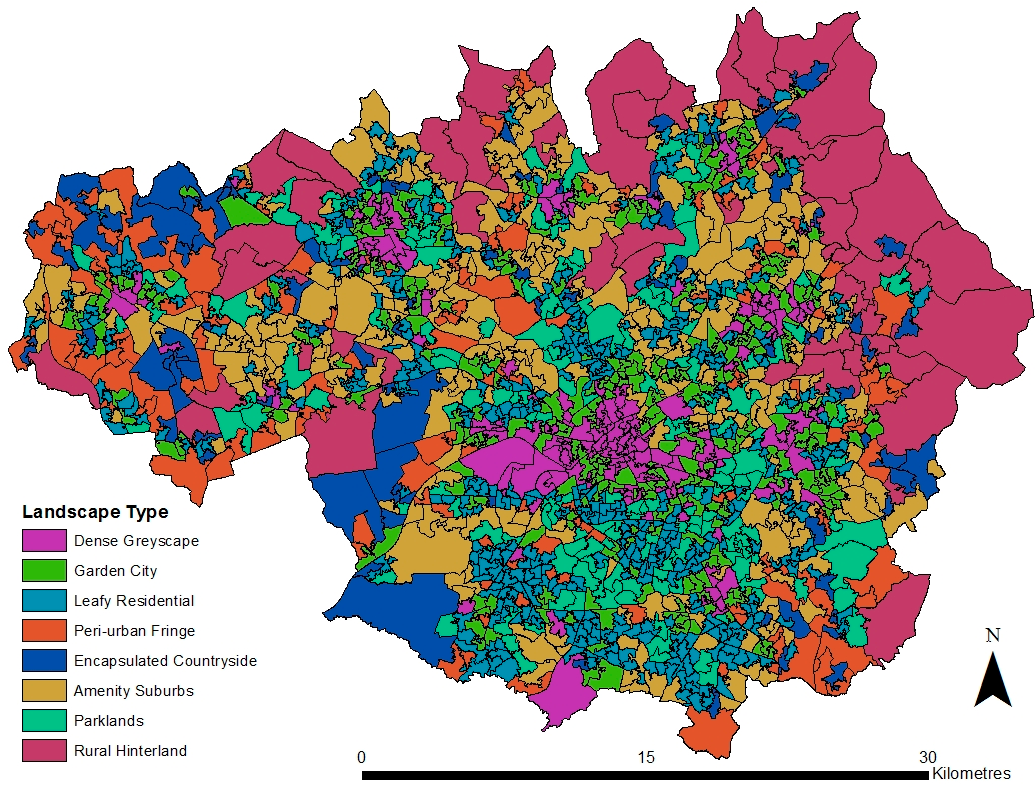
Figure 11. Distribution of LSOAs in Greater Manchester according to their landscape type with indicative labels (see Table 4; source: LSOA boundary data from ONS, 2011).